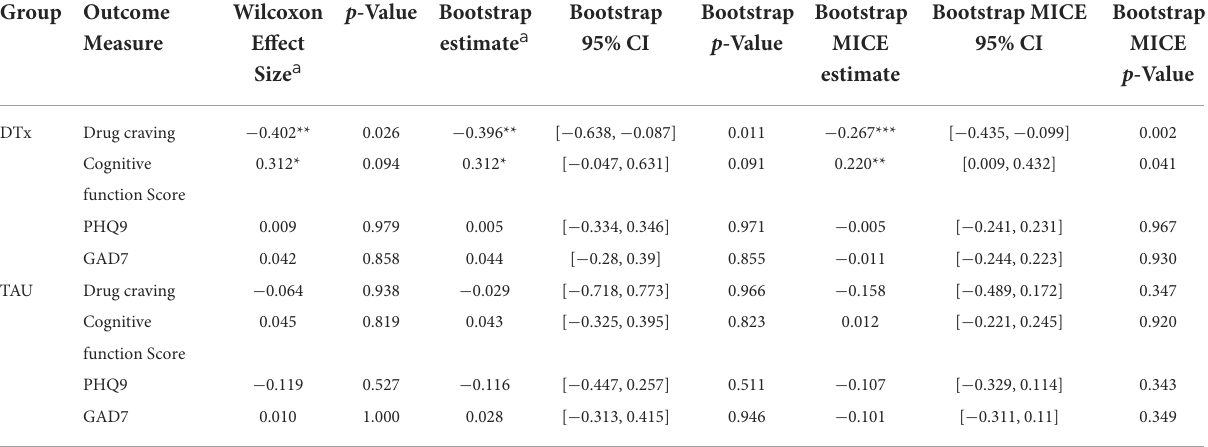
TABLE 2 Treatment effect